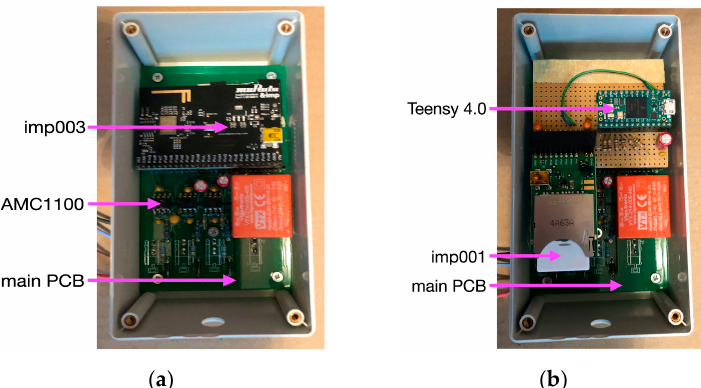
Figure 2. ( a ) Basic power meter (imp003); ( b ) upgraded power meter (Teensy 4.0 and